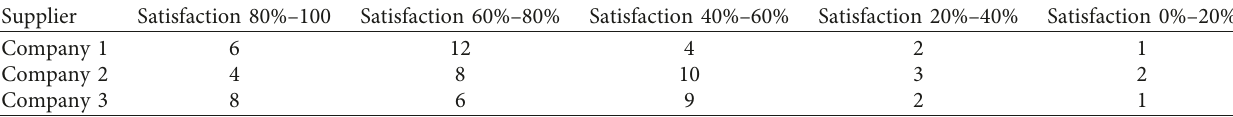
Table 1: Experimental analysis of nanomaterial purchasing